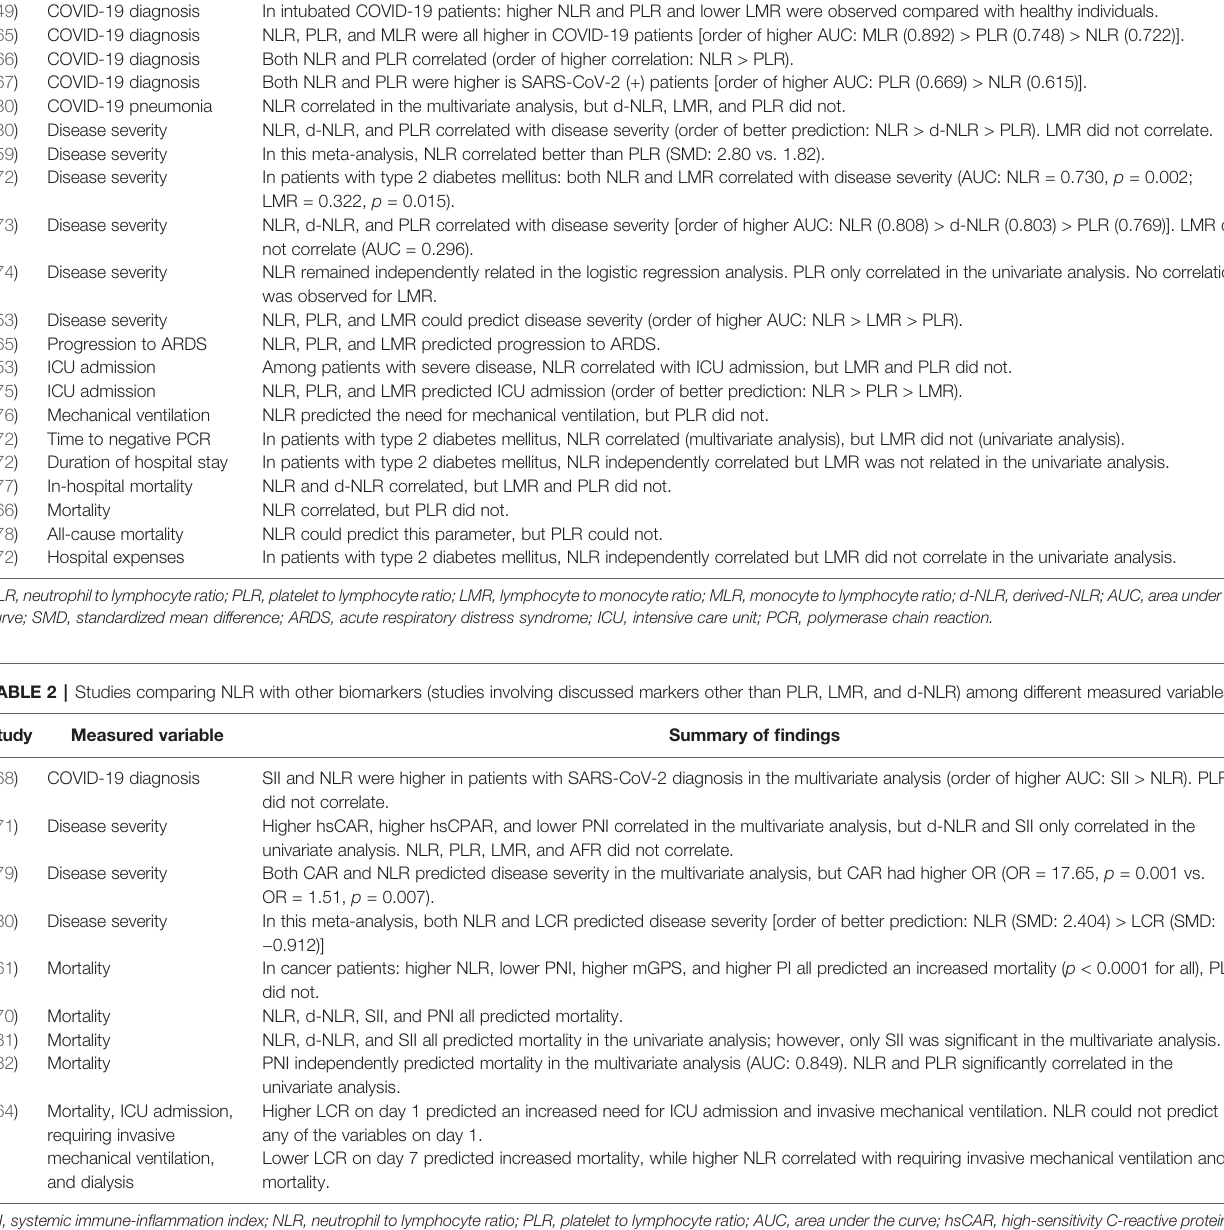
TABLE 1 | Studies comparing NLR to only PLR, LMR, and d-NLR among different measured variables. Study Measured variable Summary of fi ndings (49) COVID-19 diagnosis COVID-19 diagnosis